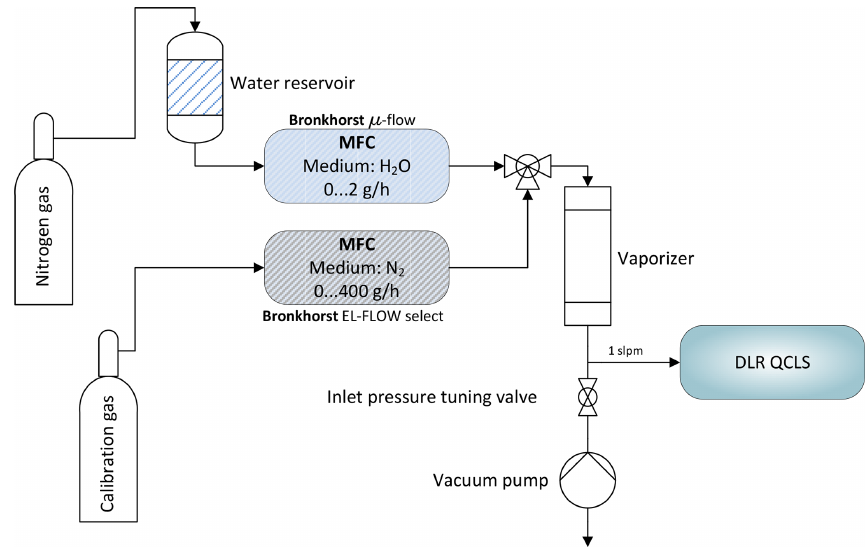
Figure 6. Schematic depicting the water correction lab setup. A reference gas can be humidified to typical atmospheric values between 0% and 2% absolute water using mass flow controllers and an electronically controlled vaporizer. A downstream pump allows for simulation of different flight